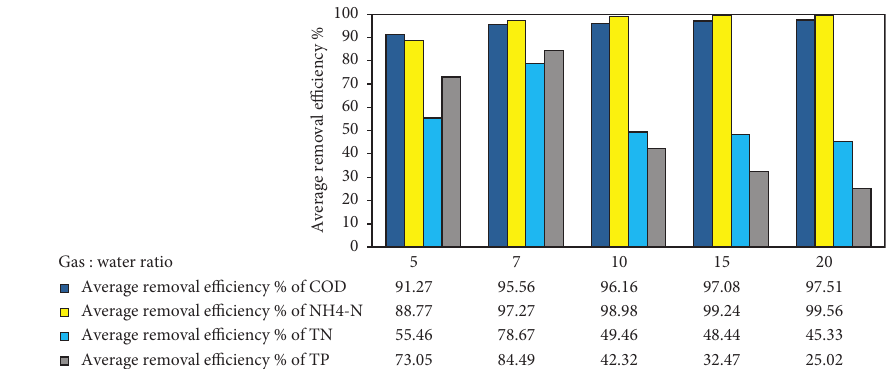
Figure 11: Average performance of A/O MBBR system under different gas :water